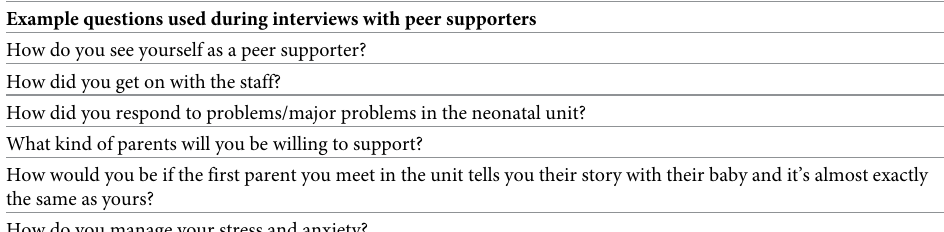
Table 4. Example questions used during interviews with peer supporters. Example questions used during interviews with peer